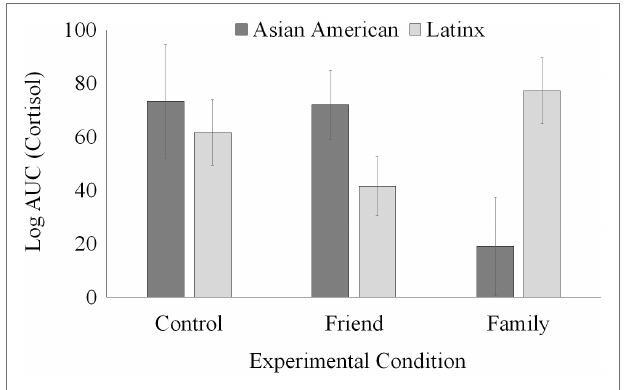
FIGURE 3 | Total salivary cortisol response by condition and